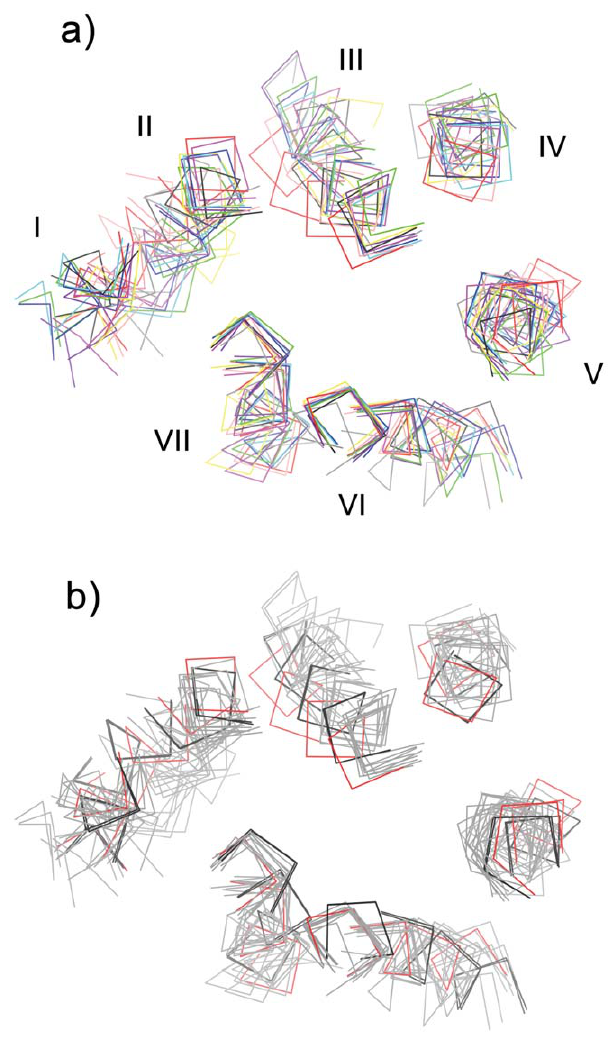
Figure 4. Projection view (from the cytoplasmic side) of molecular overlay of sections 1 and 2. a) 10 representative chains of inactivated GPCRs. b) the same inactive chains plus 2 chains of activated bovine rhodopsin. The colors in a) are the same as in Figure 1. In b), 1 inactivated chain (1U19-A) and 2 activated chains of bovine rhodopsin (PDB ID: 3PQR and 3PXO) are shown in red and black, respectively, while other chains are shown in gray.